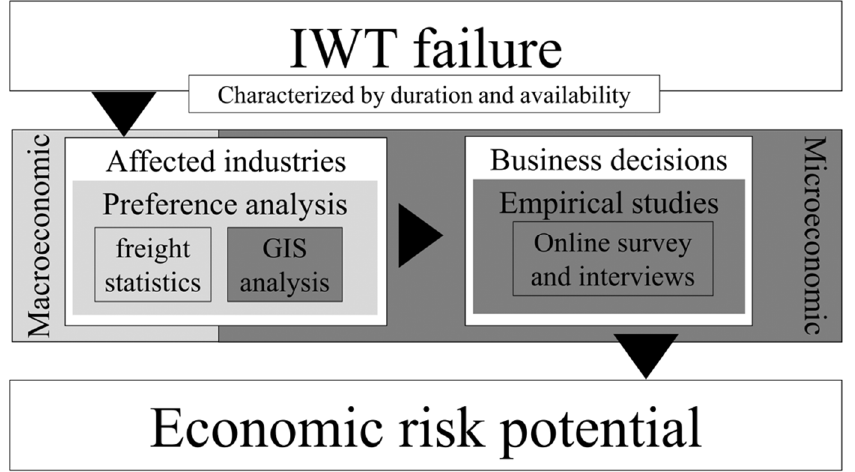
Figure 1. Research design.